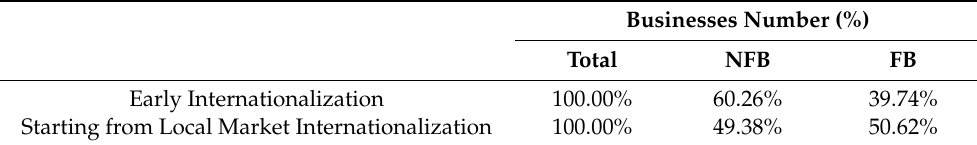
Table 1. Distribution of Small and Medium-sized Family and Nonfamily Businesses.